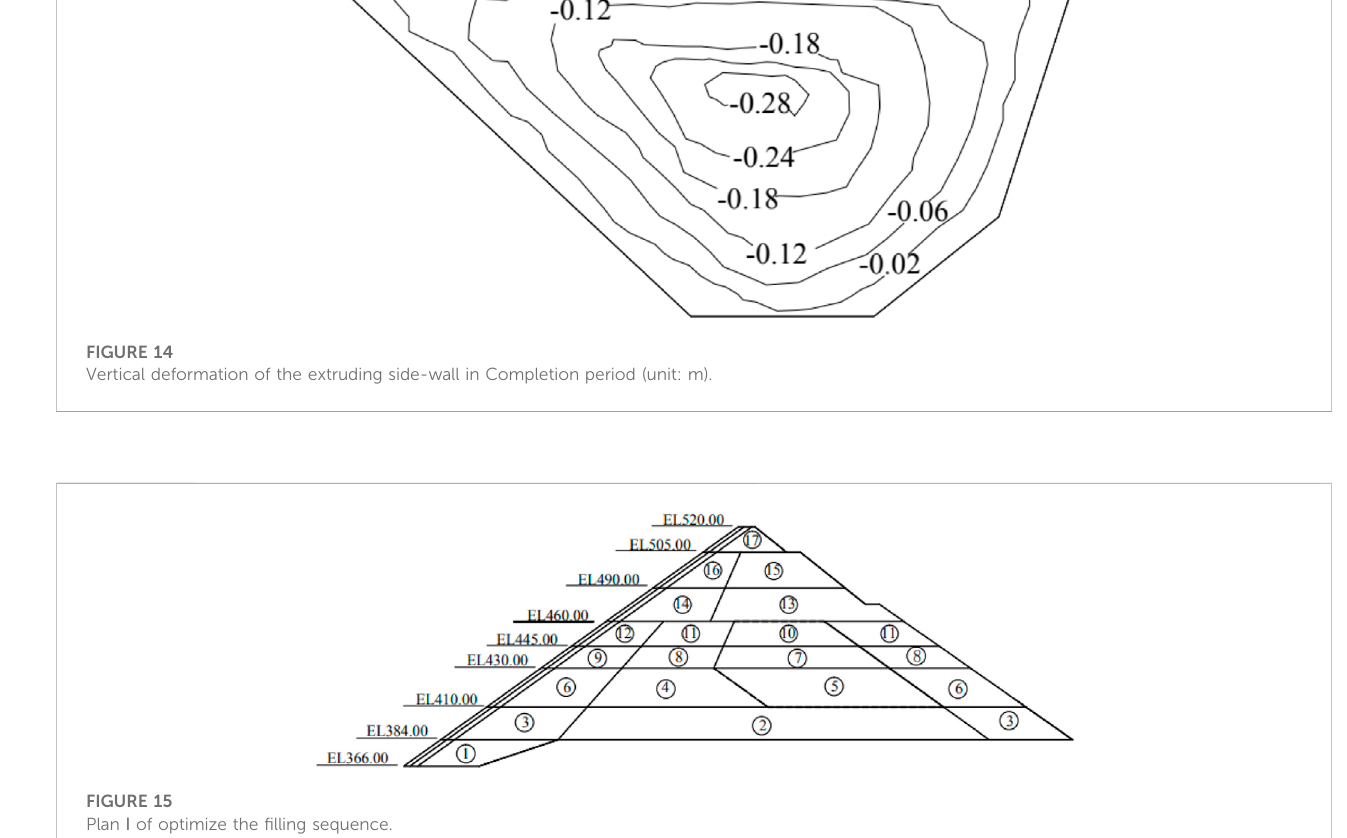
are close to this range, and some are within this range, which conforms to the principle of deformation coordination in the design of high concrete faced rock fi ll dam.